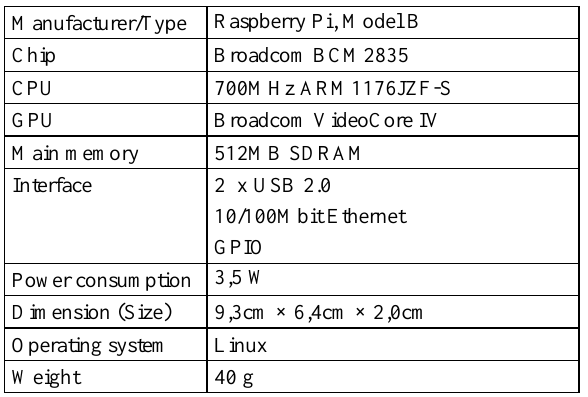
Table 5: Technical specifications Raspberry